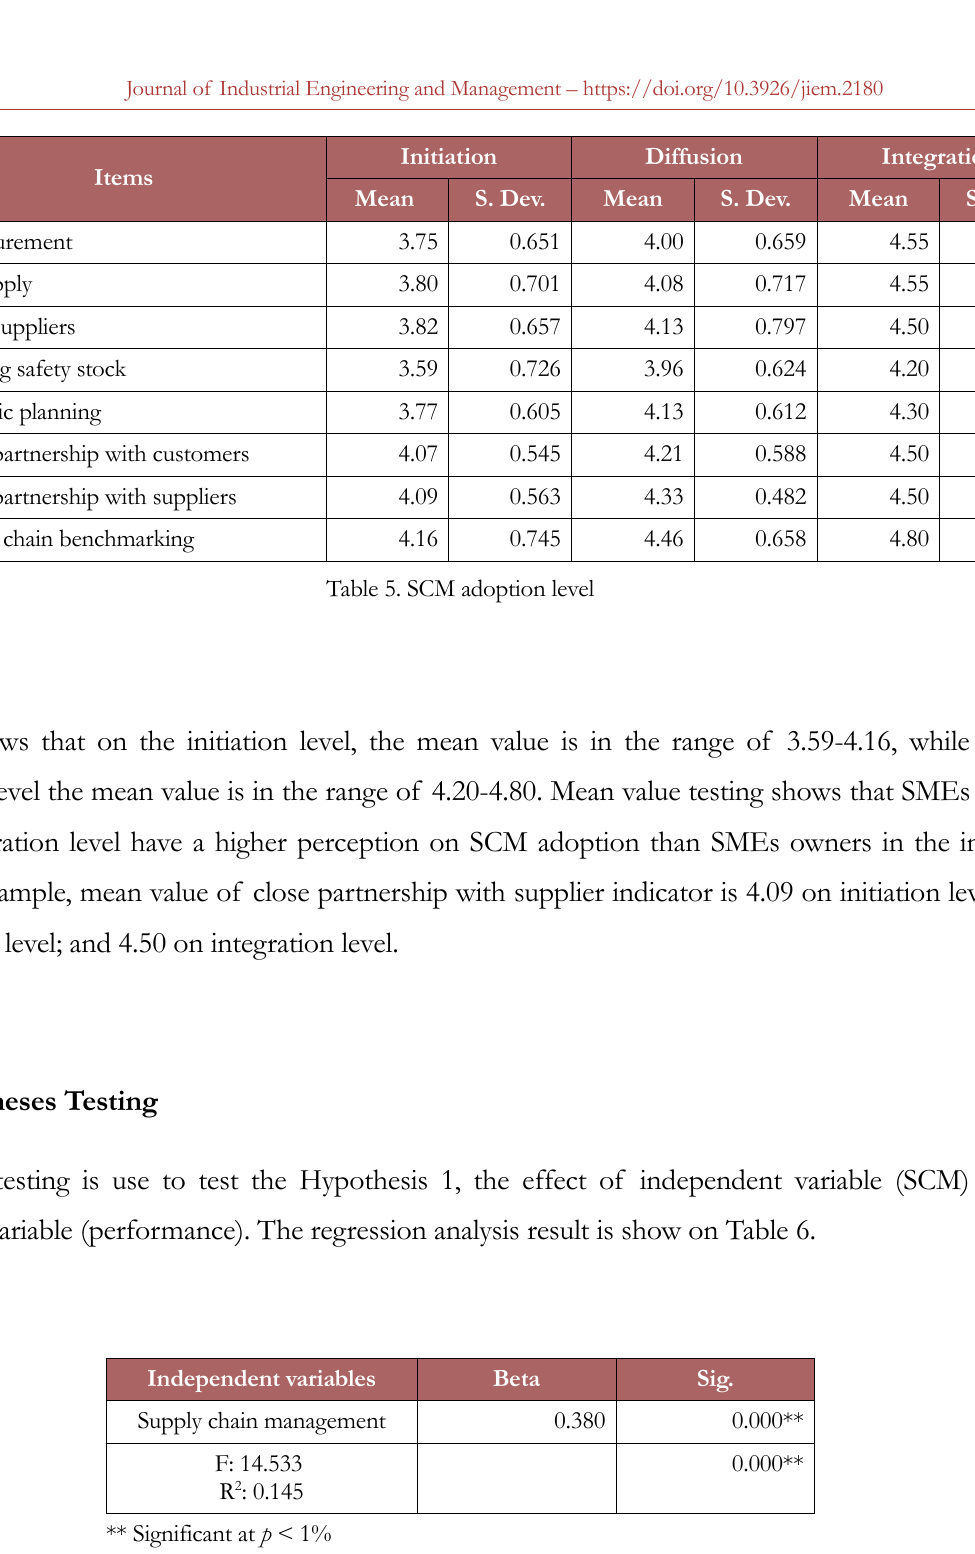
Table 6. Regression analysis